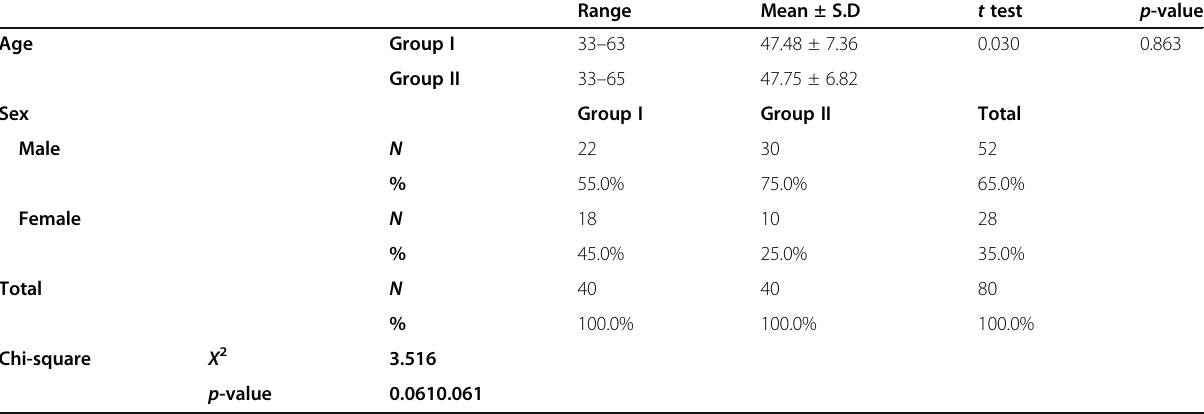
Table 1 Baseline characteristics in both